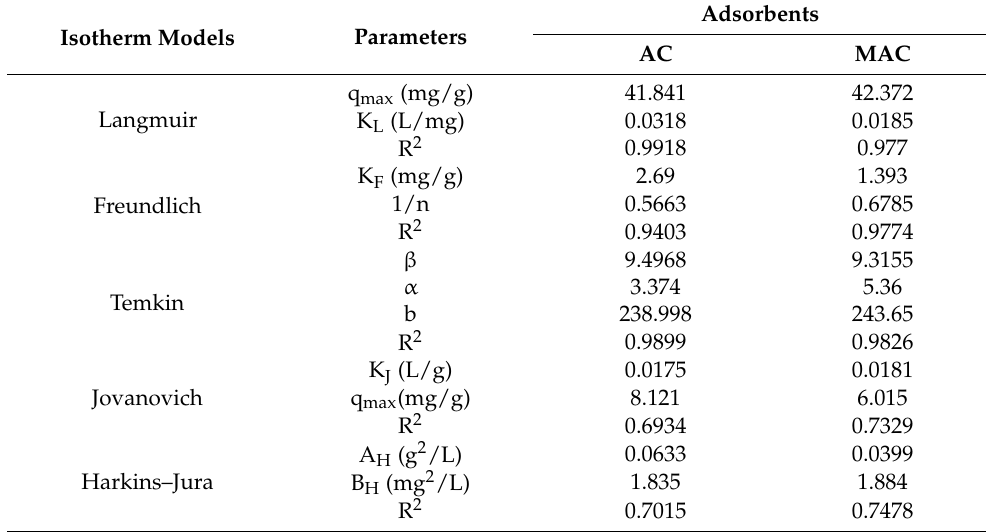
Table 2. Isothermal parameters for adsorption of AZM on AC and MAC. Isotherm